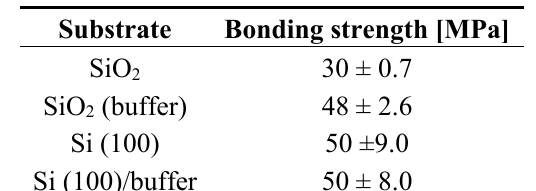
Table 1. Pull-out tensions needed for detaching carbon films from Si (100) and quartz substrates with or without a buffer